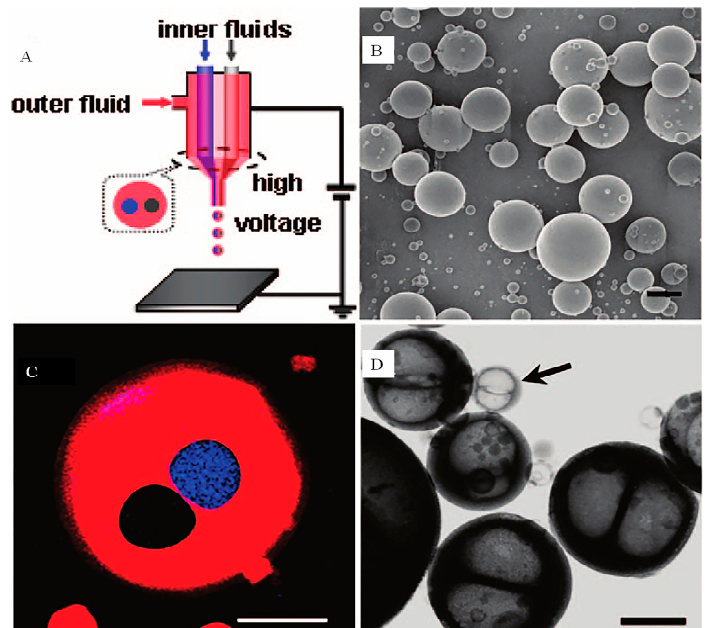
Figure 6. ( A ) Illustration of bicomponent microcapsule fabrication system. Two core liquids (blue and gray) were pumped out from two inner metal capillaries, respectively, and shell liquid (red) flowed through gaps between inner capillaries and the outer needle. ( B ) SEM image of titania composite capsules, which ranged from submicrometer to several micrometers. Scale bar: 2 μ m. ( C ) LSCM overlay image of titania composite capsules. The two core contents have been inhibited into individual compartments without contact. Scale bar: 10 μ m. ( D ) TEM image of “ θ ” structured titania bicompartment microcapsules after organics have been removed by calcination. The smallest capsule is only hundreds of nanometers as indicated by the arrow. Scale bar: 1 μ m (Adapted from [76]).